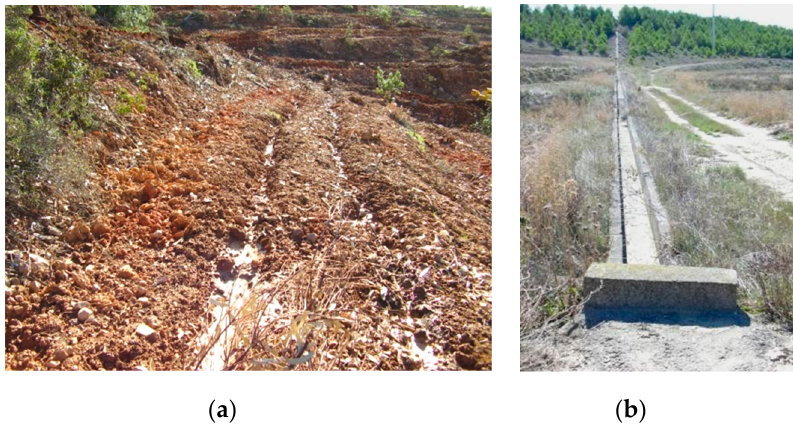
Figure 10. Mechanical initiatives to minimise runoff, facilitate recharge, and subsequent plantation ( a ) and infrastructure to channel and level excess runoff water ( b ) Neila (Castilla y León).